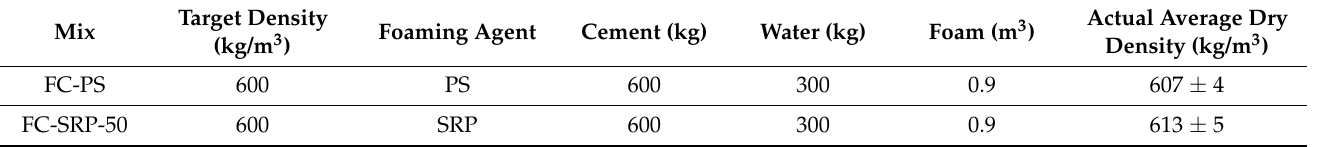
Table 3. Mix design of foam